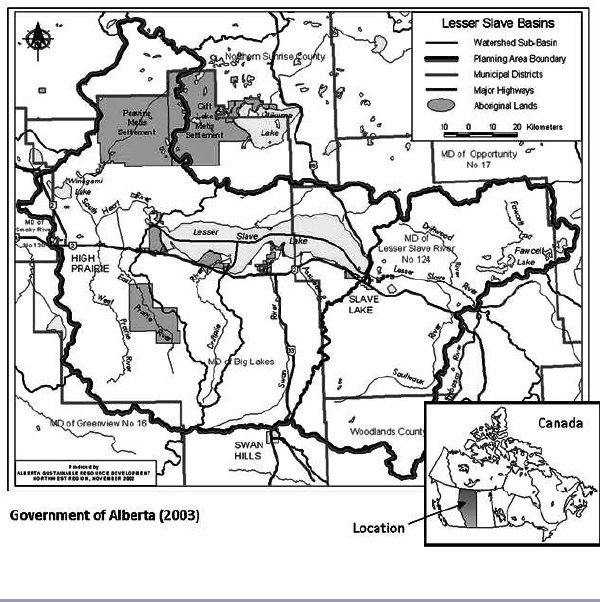
Fig. 1. Map of the study area: Lesser Slave Lake Region, Alberta,